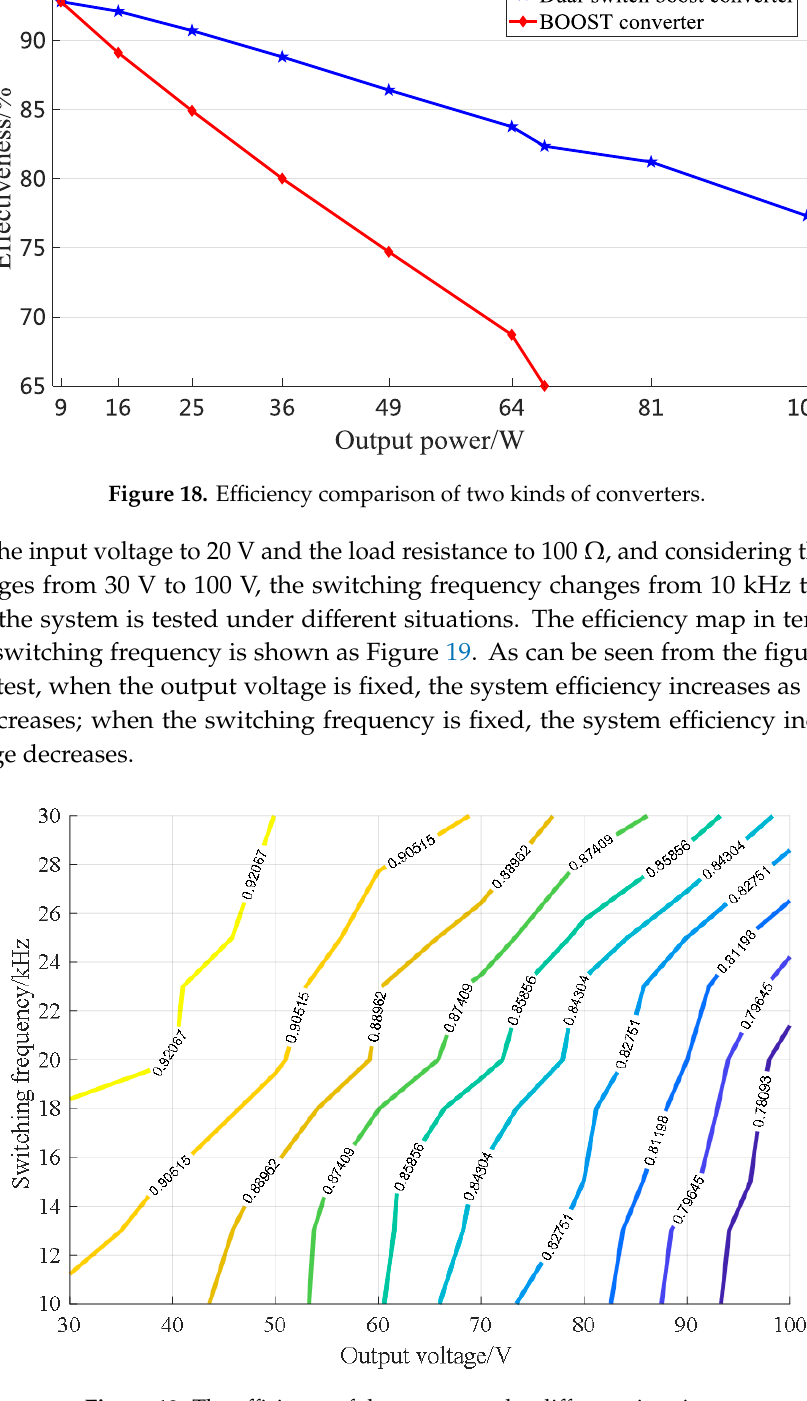
Figure 19. The efficiency of the system under different situations.